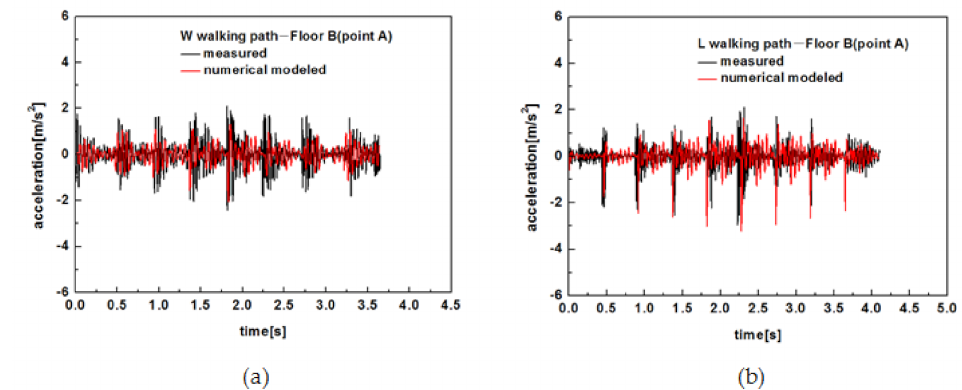
Figure 20. Acceleration responses at points A for Floor B: ( a ) W path and ( b ) L path.